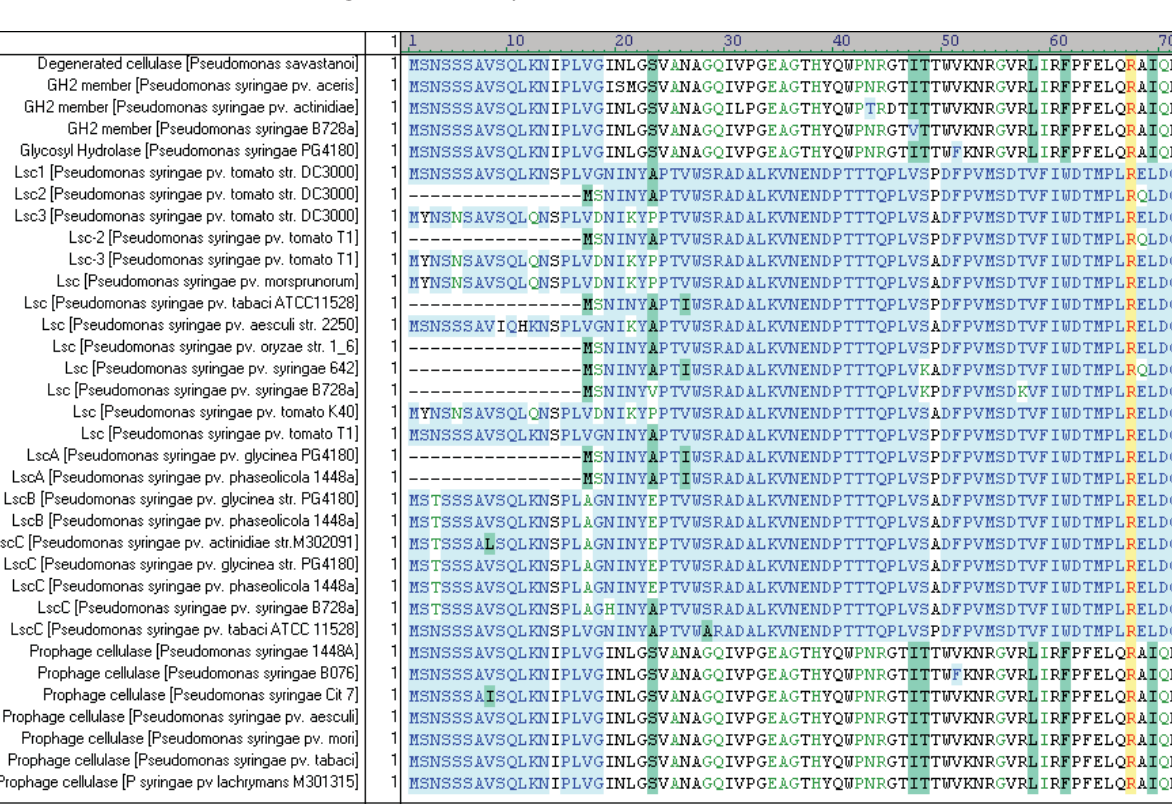
Figure 4. Amino acid sequence alignment of N-termini of predicted gene products (variant A, variant BC, putative pro-phage-borne glycosyl hydrolase). A 16 residue-spanning conserved sequence in variant BC and the glycosyl hydrolase is missing in variant A. Color coding: blue — conservative residue, green — block of similar residues, yellow/orange — identical residues, white/green — weakly similar residues, black — non-similar